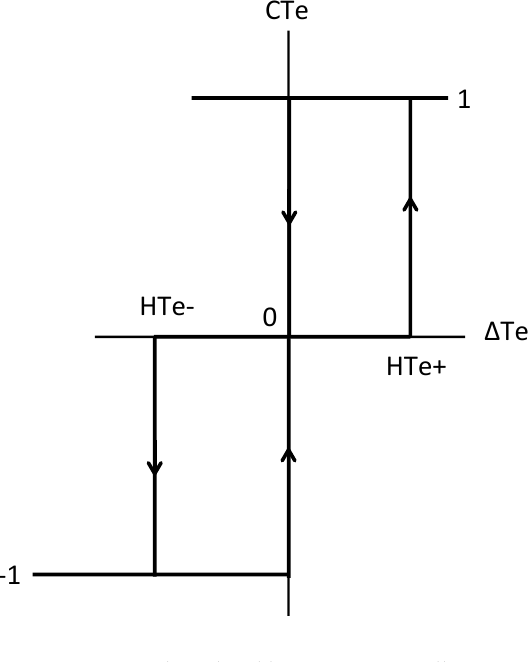
Figure 6. Three-level hysteresis controller. Table 1. Possible states of the inverter.